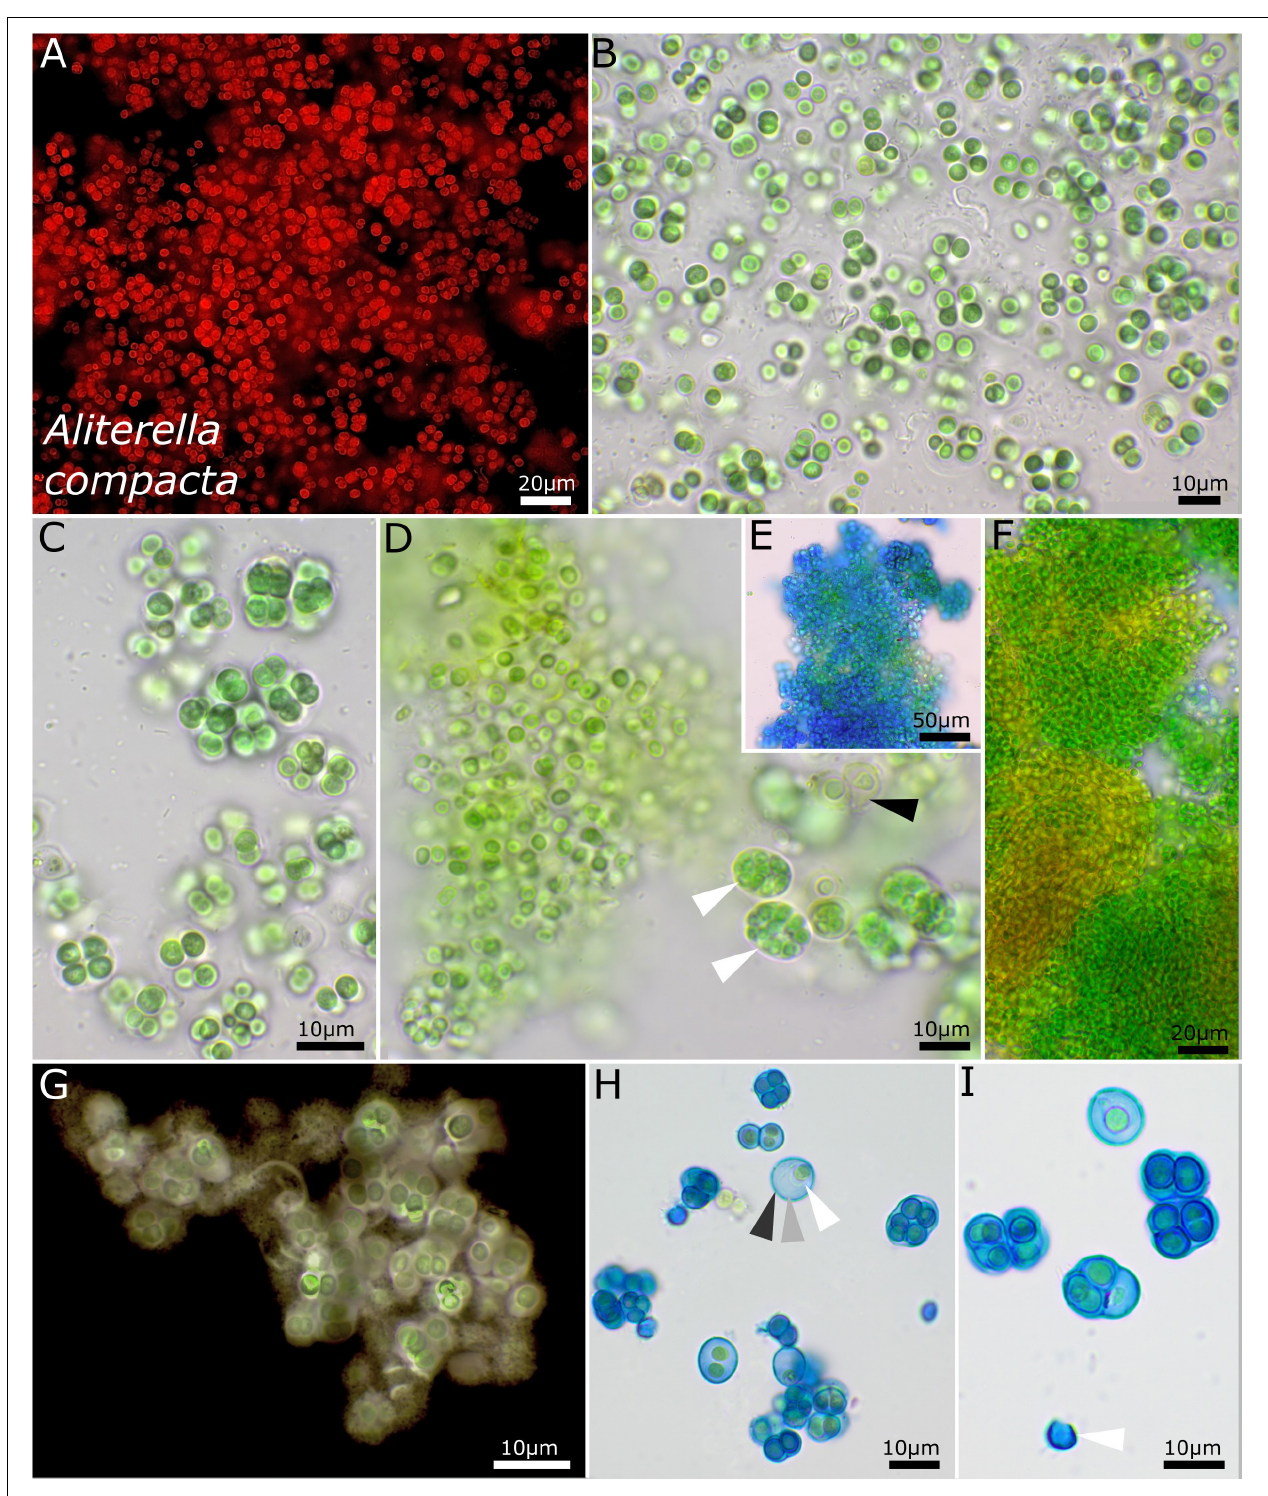
FIGURE 2 | Micrographs showing Aliterella compacta . (A) Fluorescence microscopy and (B–I) light microscopy. (A–C) Rounded single cells embedded in rounded, limited sheaths. (D) White arrows indicate compact groups of young, pressed cells encapsulated in firm sheaths (= baeocytes); black arrow points toward wide sheaths of older cells. (E) Stained with ACN solution colorizing firm and non-diffluent sheath material of colonies. (F) Single cells arranged in dense colonies, with older parts turning yellow. (G) Indian ink staining of colony indicating firm, non-diffluent sheath matrix. (H,I) ACN staining showing limited and lamellate sheath material with three layers as marked with arrows in (H) and an empty, capsule-like sheath in (I) .